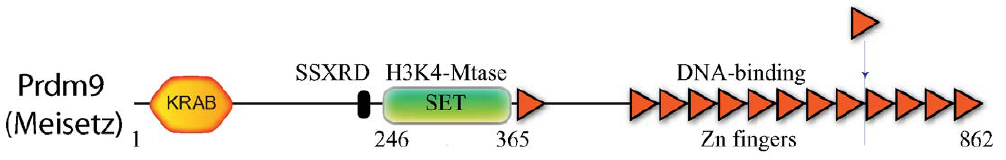
Figure 1. Schematic of Prdm9 protein encoded by M.musculus . Schematic of the domain architecture for the long protein isoform encoded by the M. musculus Prdm9 gene. The Prdm9 protein contains KRAB, SSXRD, and SET domains and a single zinc finger in its N-terminal half, while the C- terminal half consists of an array of zinc finger domains [17]. The shorter Prdm9 protein isoforms lack the C-terminal zinc fingers and apparently do not localize to the nucleus. Sterility and fertility associated alleles of Prdm9 in M. m. musculus differ only in one extra zinc finger (red triangle)